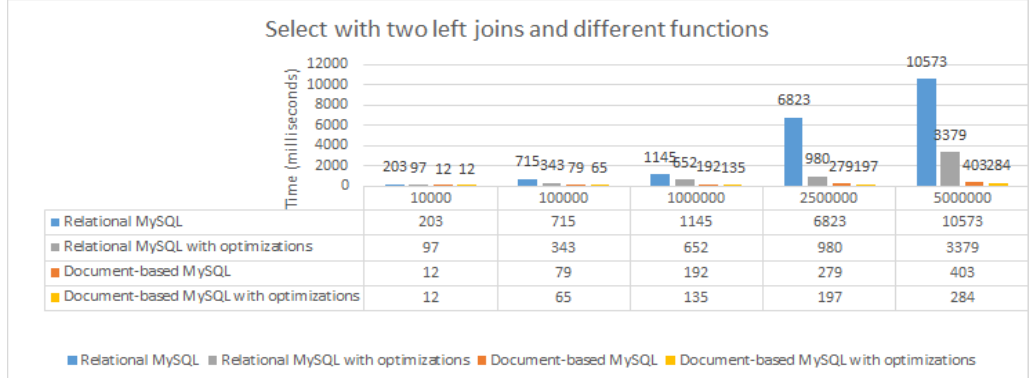
Figure 12. Performance time (ms) for the select operation with two left joins and different func- tions.